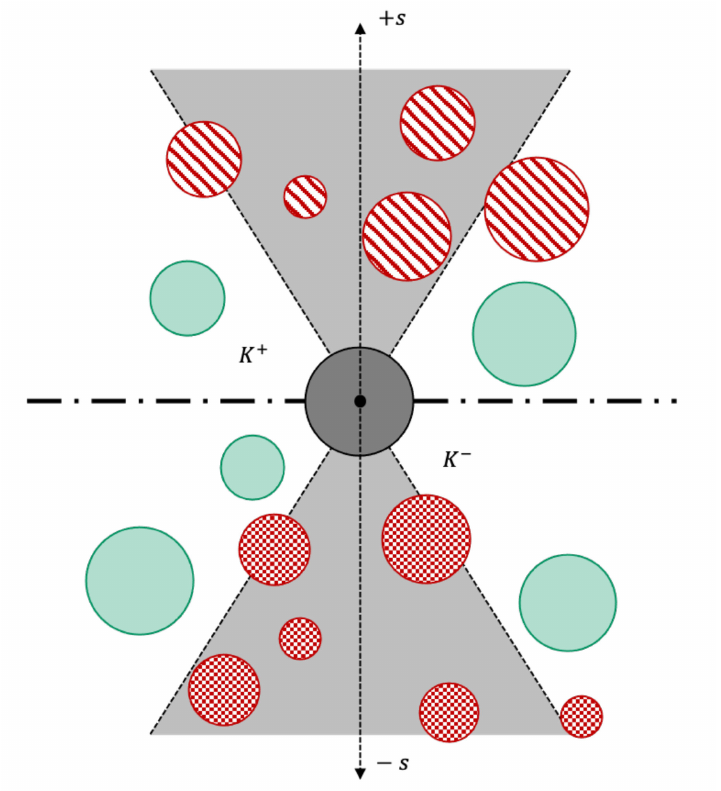
Figure 5. Visualization of the conflict cones in the positive (+ s ) and negative ( − s ) direction. Conflict spheres in red and conflict-free spheres in green. The conflict spheres in the positive direction are stored in K + , while the conflict spheres in negative direction are stored in K −